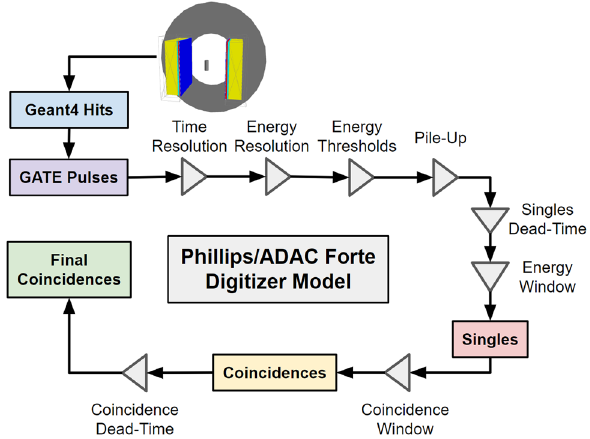
Figure 4. The digitizer model of the ADAC